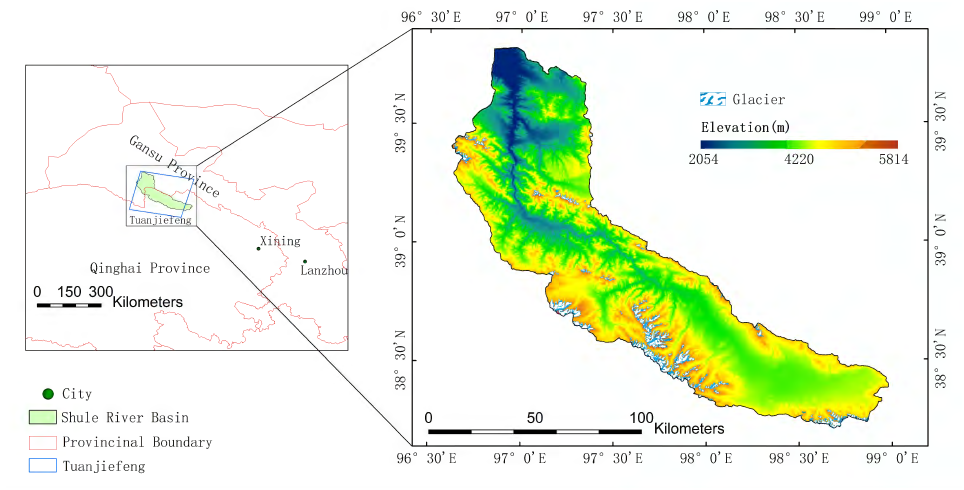
Figure 1. Location of Upper Reach of Shule River Basin, the blue box in left panel is Tuanjiefeng